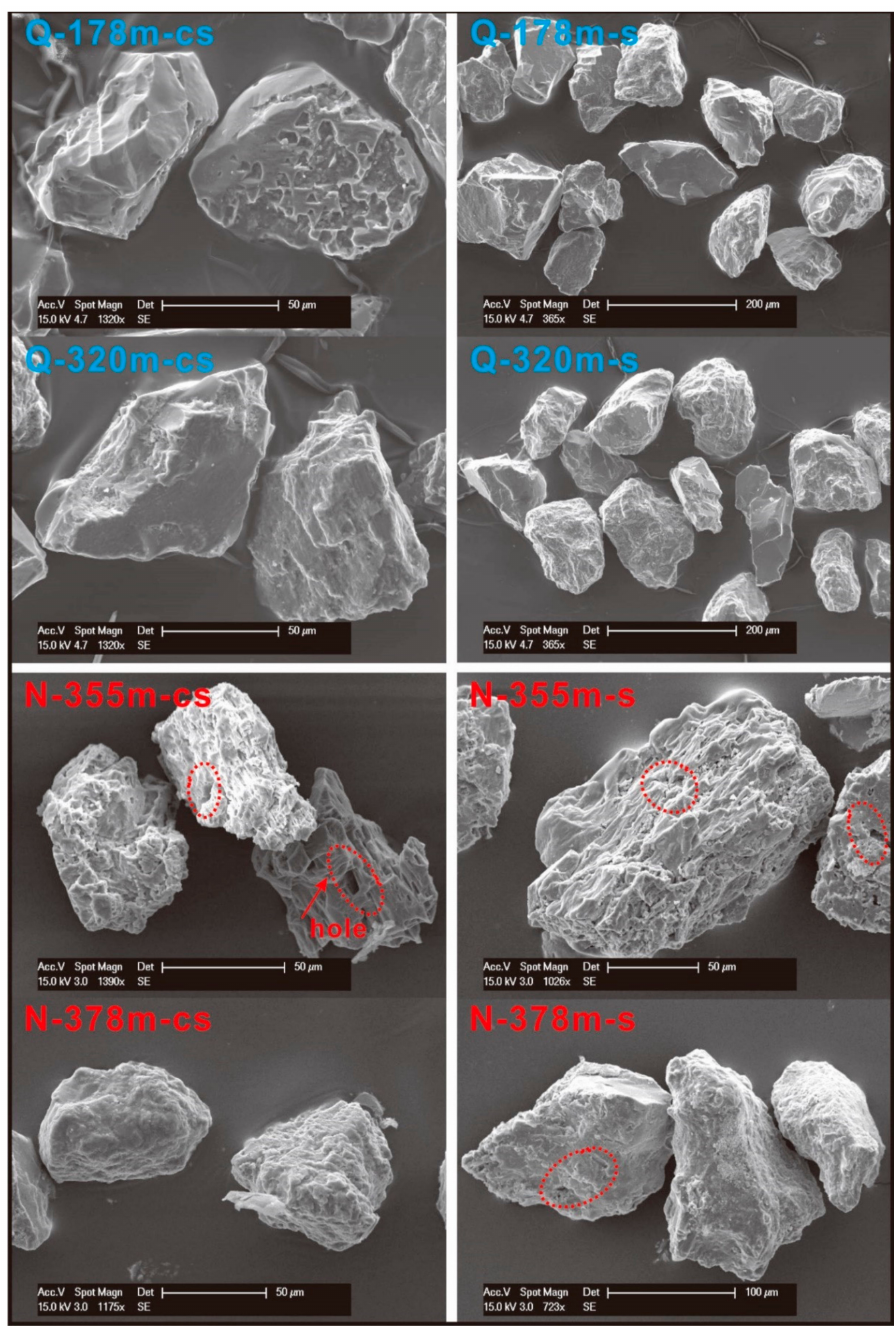
Figure 10. Surface texture of the epidote in the Core LQ24 of the Changjiang Delta. s = Very fine sand fraction (63–125 µ m), cs = coarse silt fraction (32–63 µ m). N = Pliocene, Q =